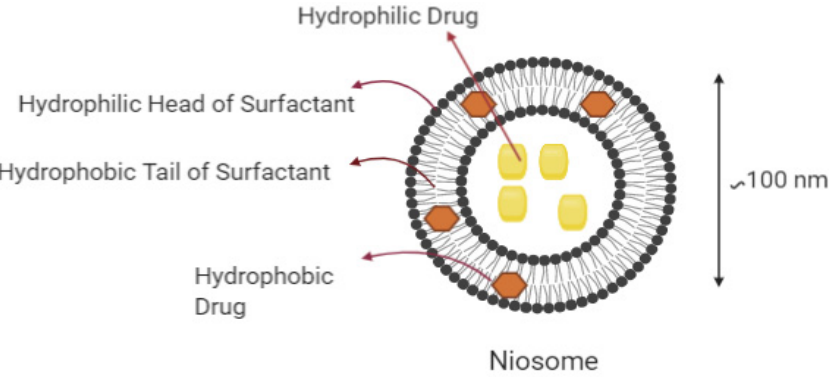
Figure 4. Structure of niosomes for the transfer of various drugs to target locations.